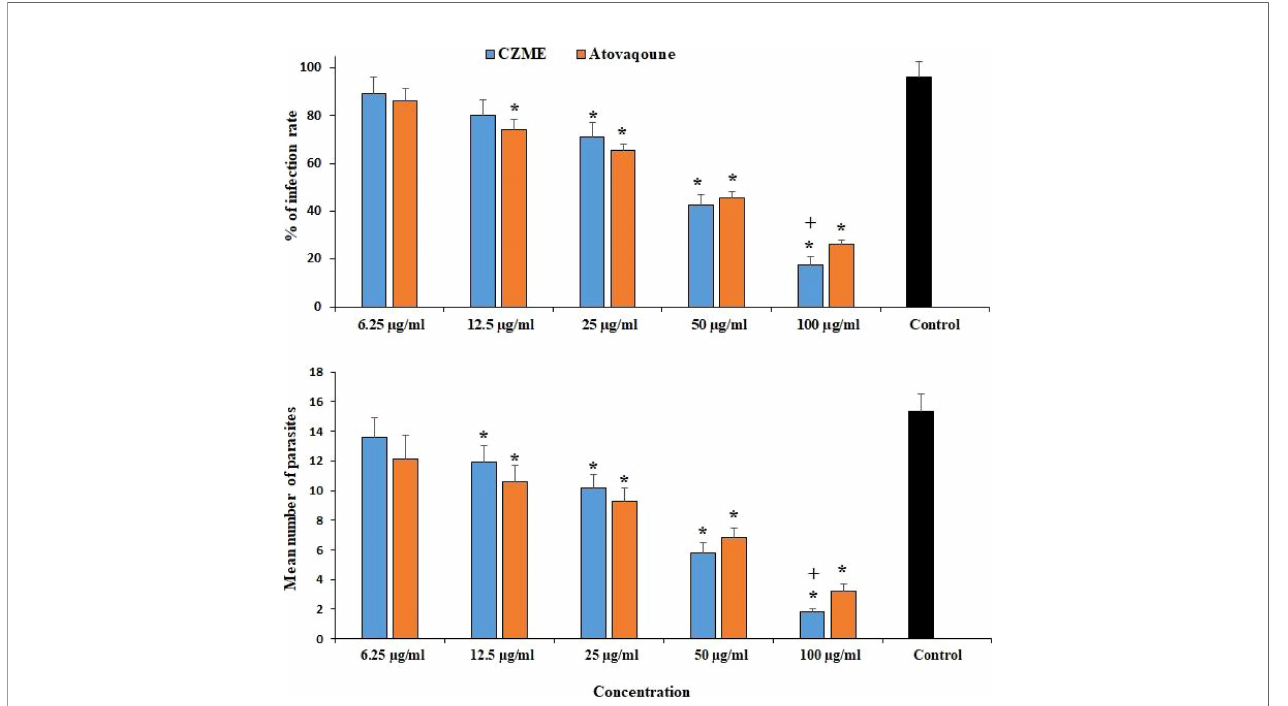
FIGURE 2 | Effect of C. zeylanicum methanolic extract (CZME) on the infection rate of the Vero cells and mean number of intracellular parasites after 3 h incubation. Mean ± SD (n = 3). *p <0.001 compared with the control group; +p <0.05 compared with atovaquone.